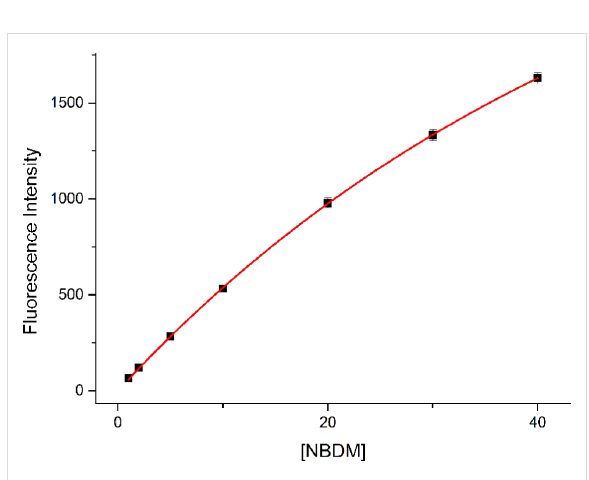
Figure 2: NBDM fluorescence from 1–40 µM (PBS buffer). The data set was plotted in OriginPro 8.6 and fitted using a self-quenching model, with direct